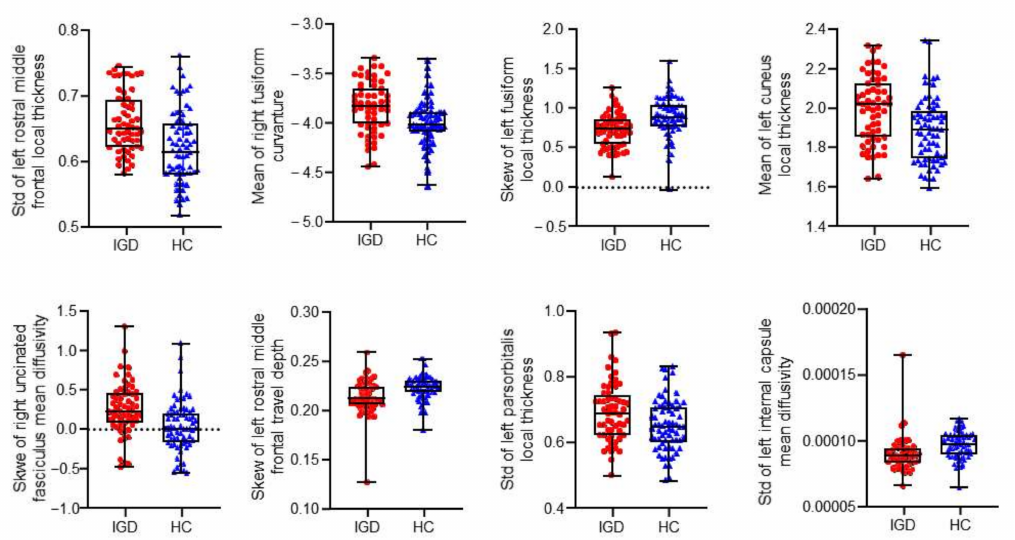
Figure 3. Identified features that discriminated IGD subjects and HCs. IGD = internet gaming disorder; HC = healthy control; std = standard